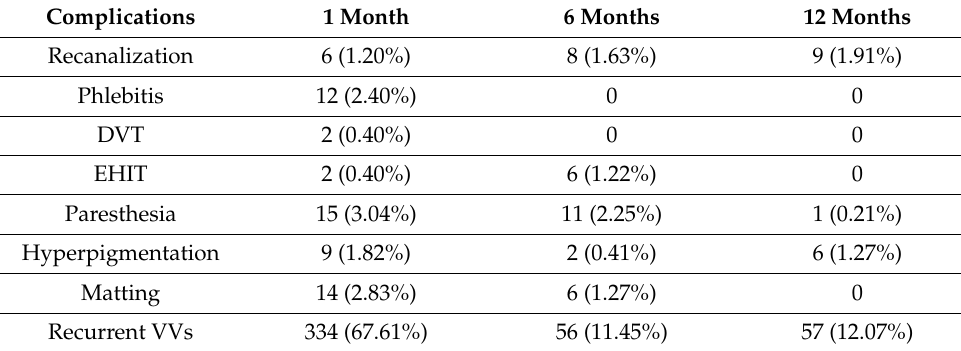
Table 4. The mean Venous Clinical Severity Score